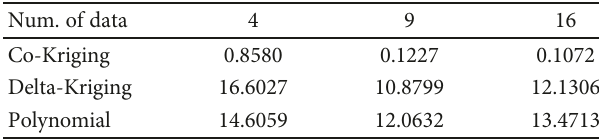
Figure 7: Results with 16 high LoF data points: (a) Co-Kriging method, (b) delta-Kriging method, and (c) polynomial method. Table 1: Mean relative square error.